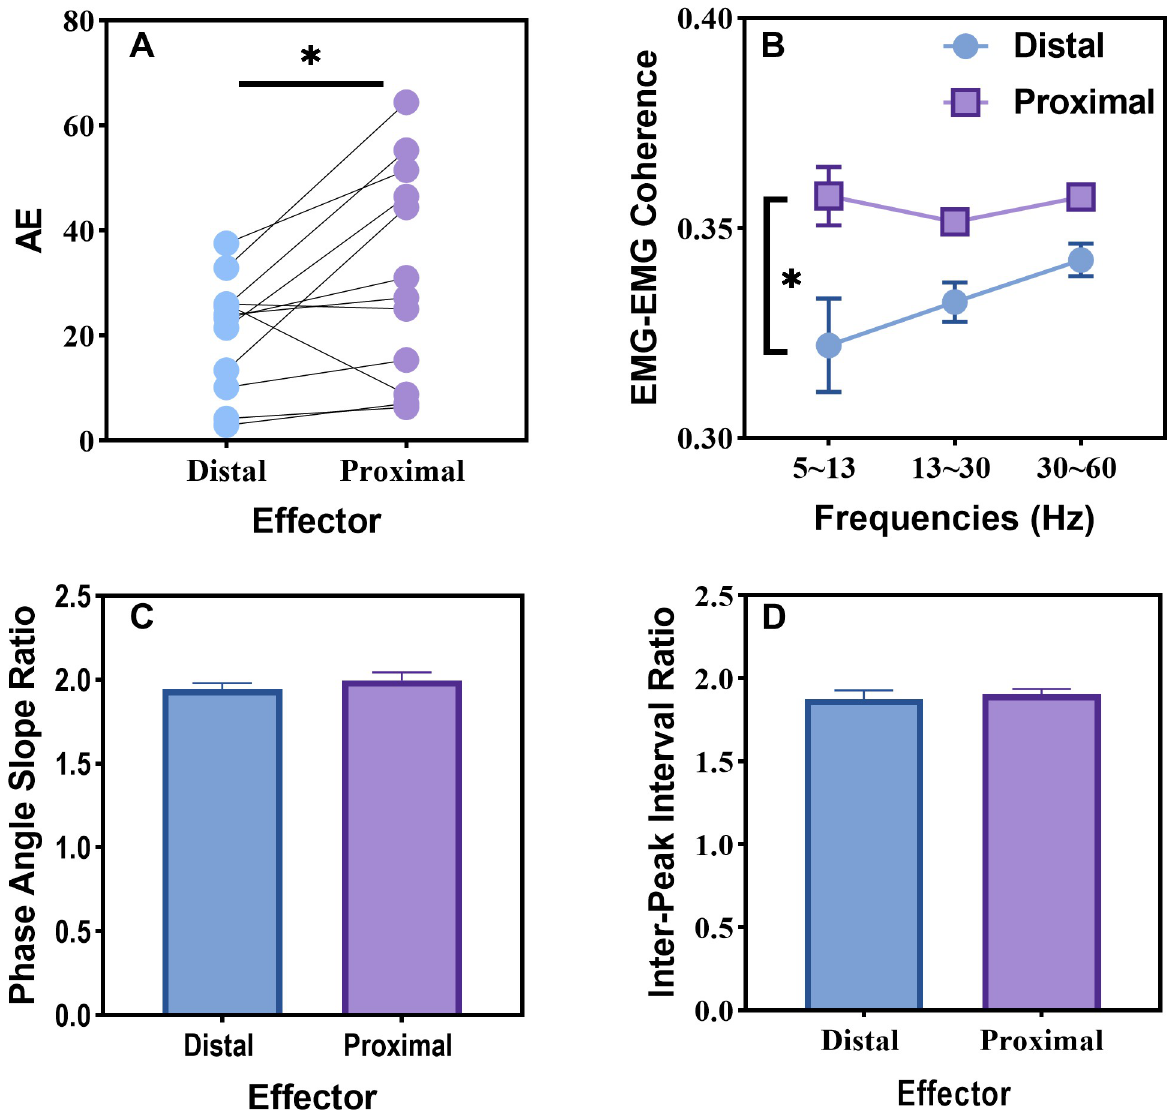
Fig 5. Bimanual measures. (a) Absolute error for distal and proximal effector, (b) EMG-EMG coherence for distal and proximal effector in the alpha (5–13 Hz), beta (13–30 Hz), and gamma (30–60 Hz) frequency bands, (c) phase angle slope ratio, and (d) inter-peak interval ratio. The � indicates a significance level less than 0.05.